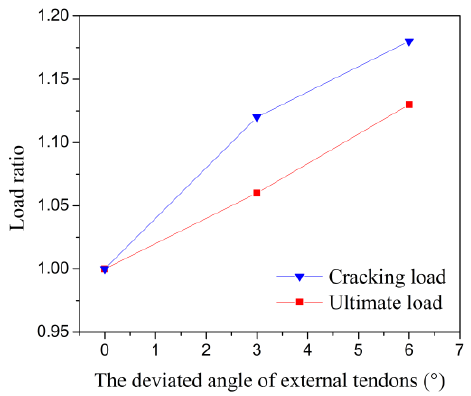
Figure 16. The influence of αp on flexural capacity.